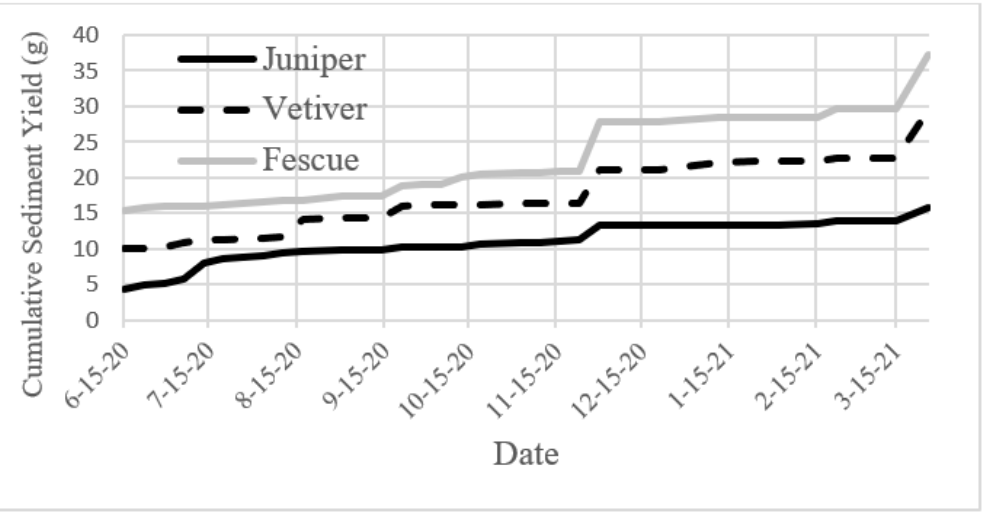
Figure 6. Cumulative sediment yield during the first year of the study measured using the runoff collection with TSS method.